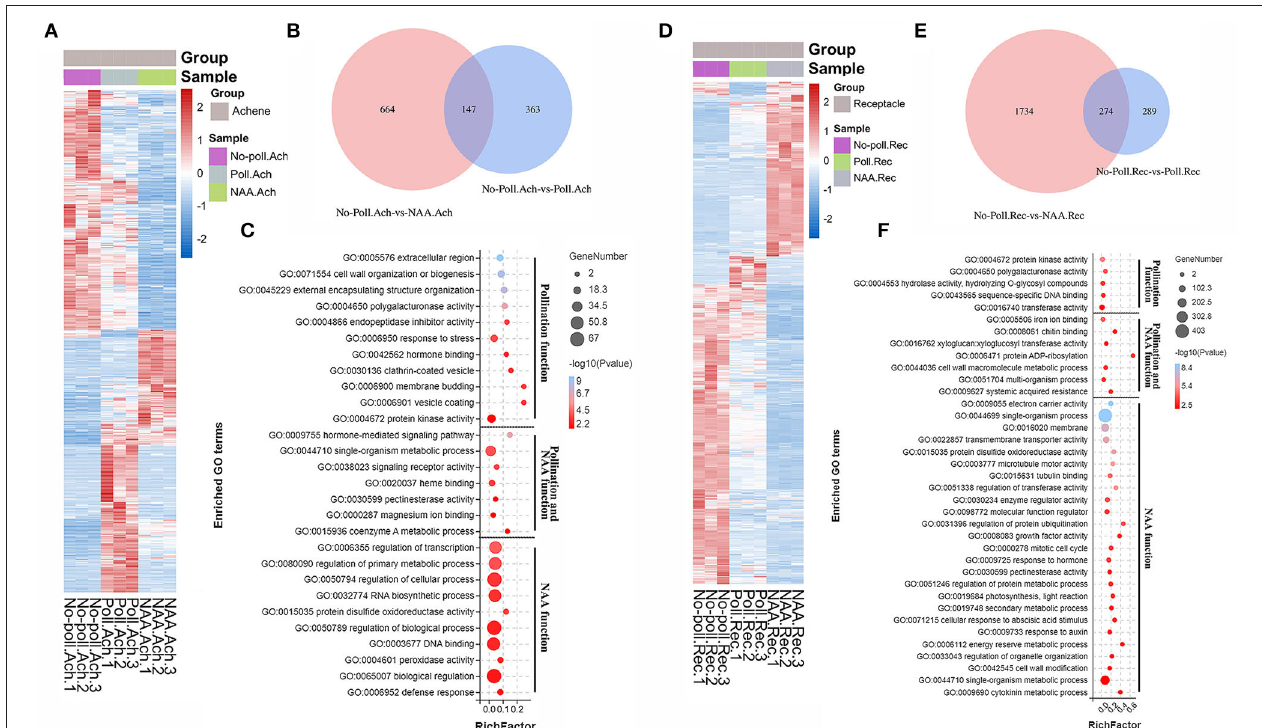
FIGURE 6 | Gene regulation of auxin was much different in pollination during fruit set. Heatmap analysis of 1174 DEGs for achenes (A) and 2297 DEGs for receptacles (D) that were differentially regulated by pollination or NAA treatment. P < 0.05, |log2(fold change)| > 1.5. Expression values were converted into log2(value + 10 − 6 ). (B,E) Distribution diagrams of the DEGs identified in achenes and receptacles responding to pollination and NAA treatments. P < 0.05, |log2(fold change) > 1.5|. (C,F) GO enrichment for the DEGs differentially regulated by pollination and NAA in achenes (C) and receptacles (F) . Legend in the right shows the enriched gene numbers and log10(P value). Function of pollination and NAA was analyzed separately. P < 0.05.